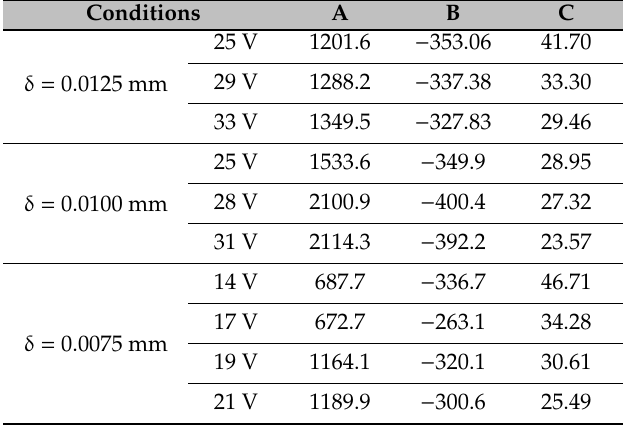
Table 3. Coe ffi cients of Nusselt number in Equation